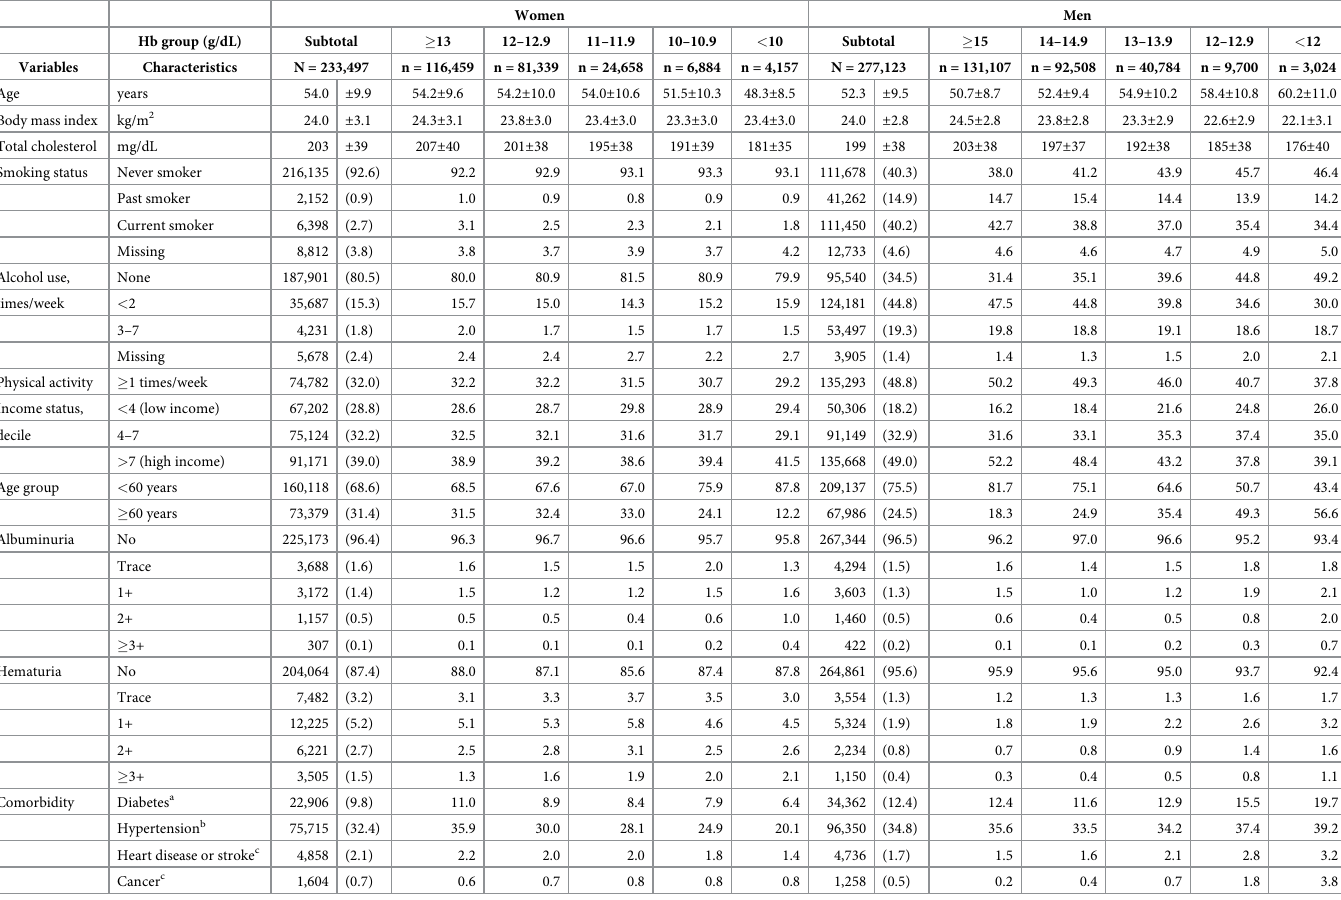
Table 1. Characteristics of participants according to sex and Hb